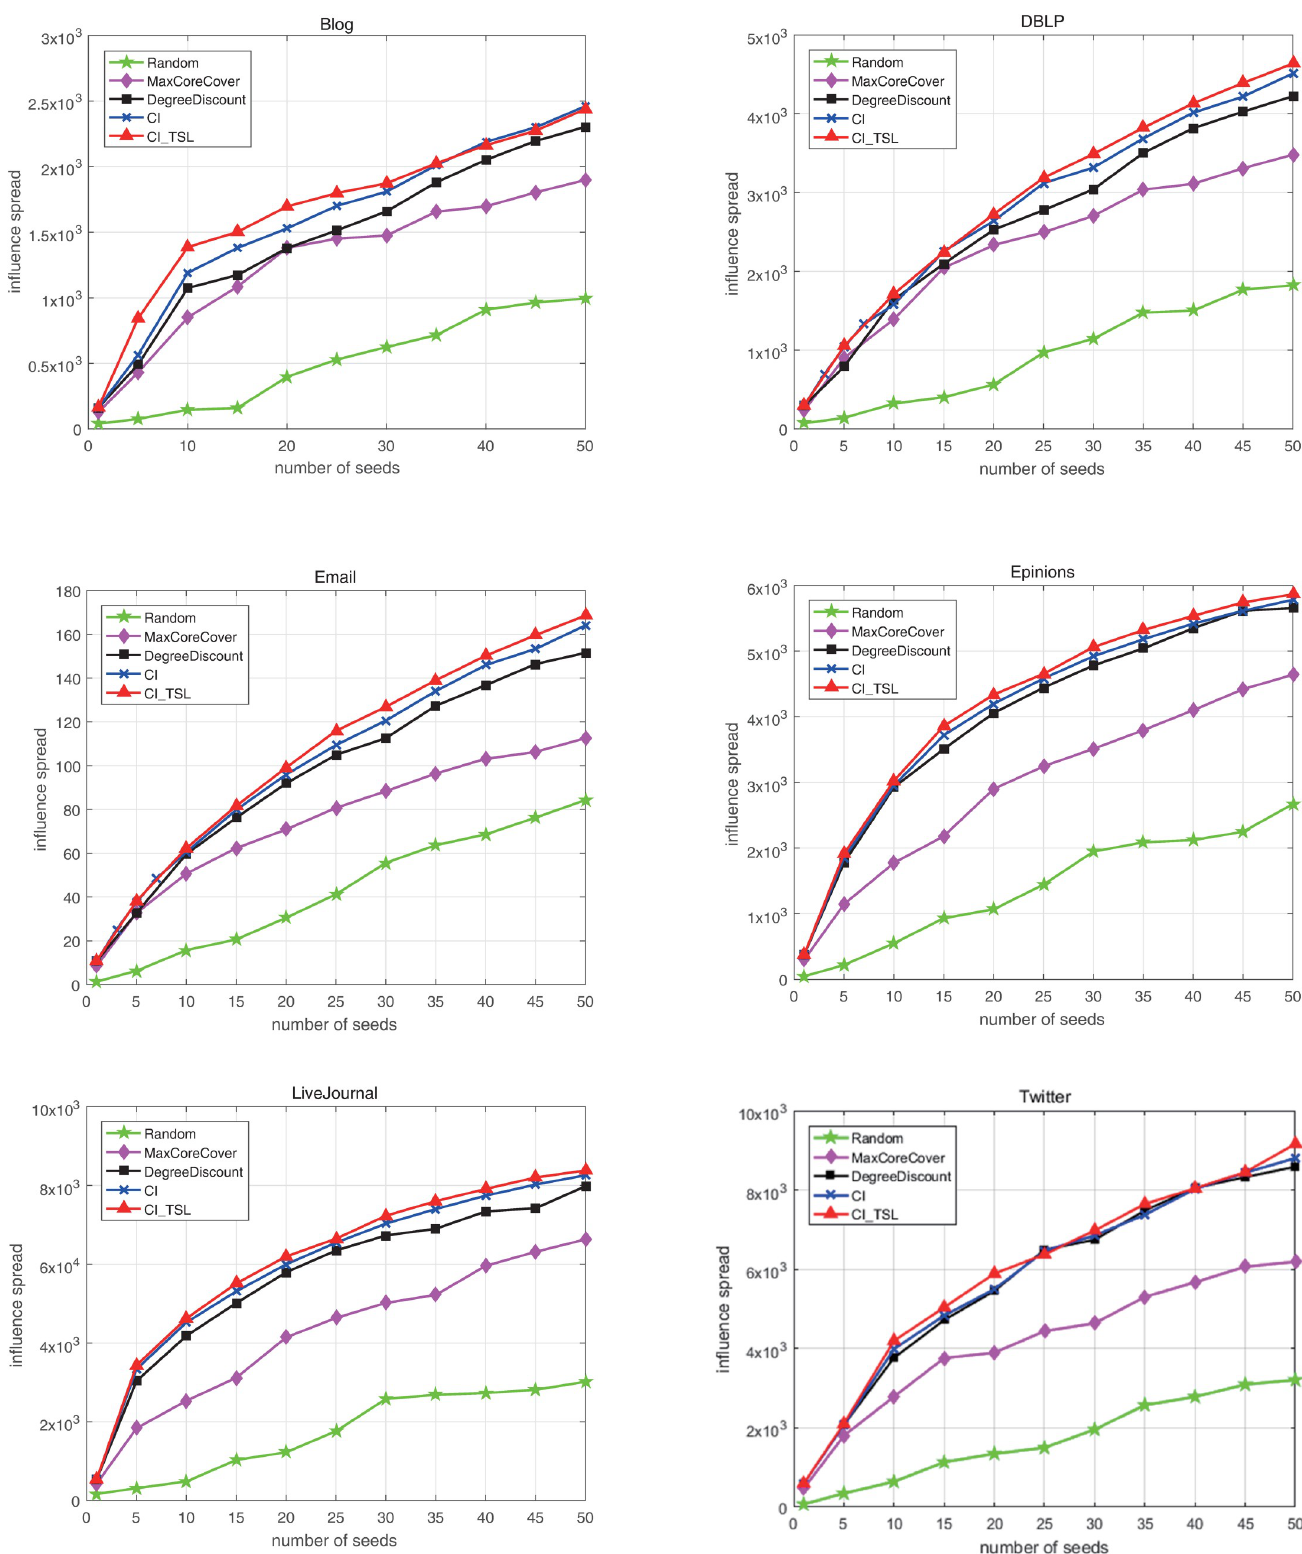
Fig 4. Spreading influence results of five algorithms for six networks.